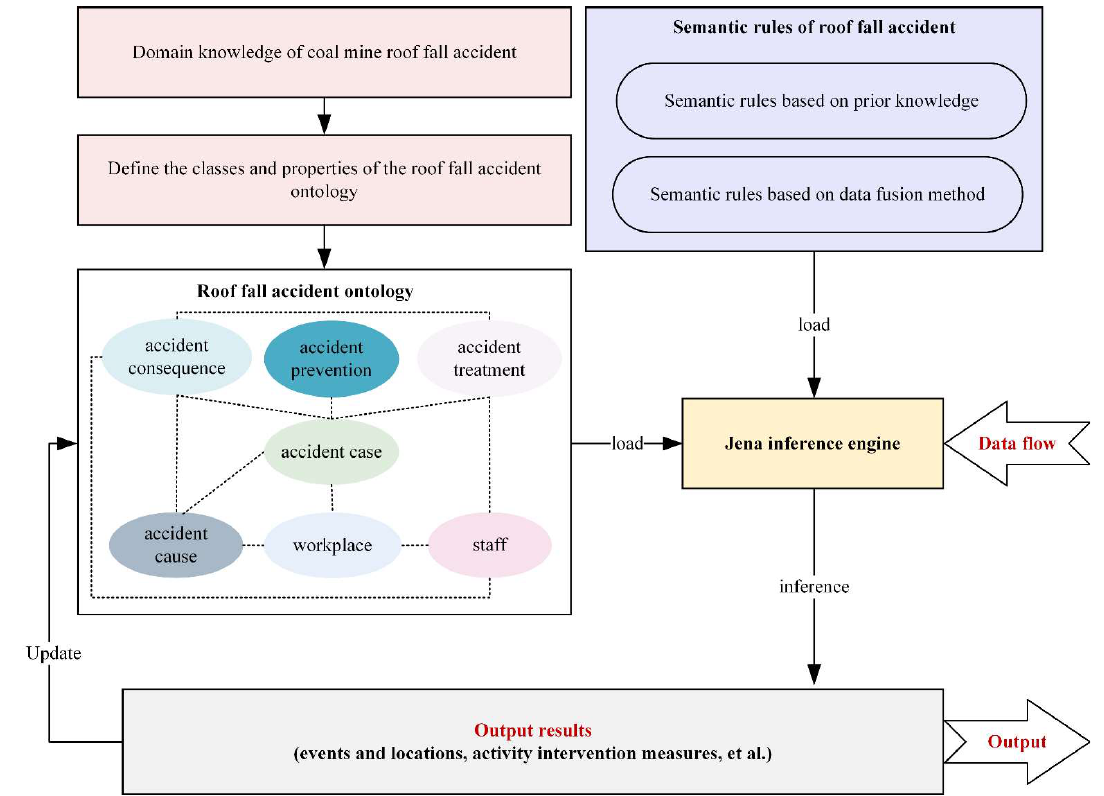
Figure 3. Flow chart of ontology-based semantic modeling of the roof fall accident.